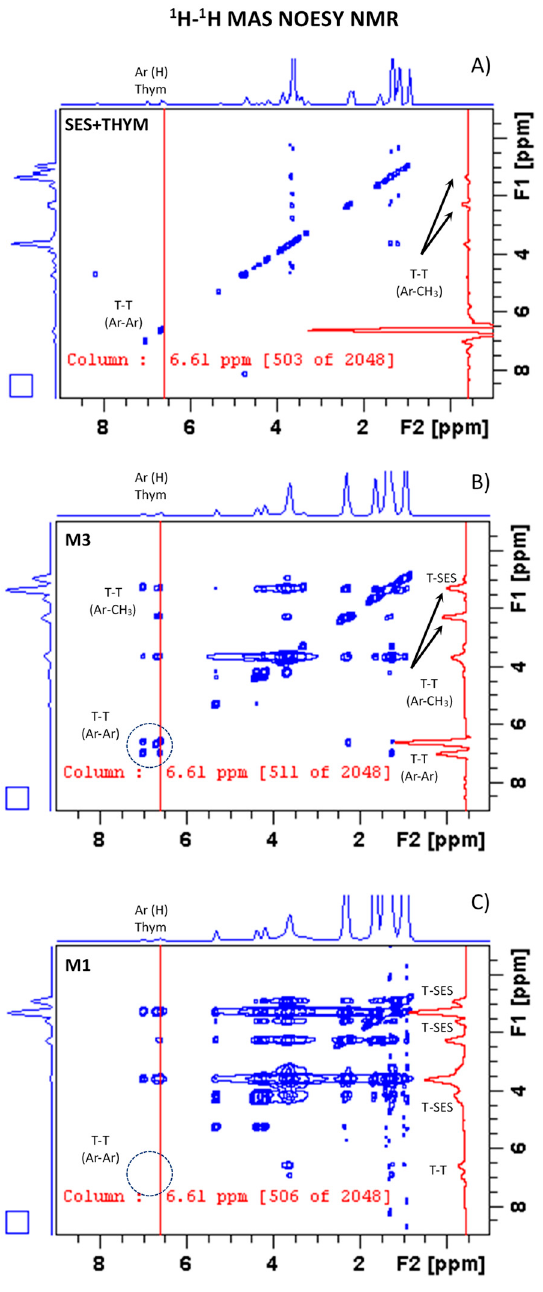
Figure 8. The 1 H- 1 H MAS NMR correlation spectra recorded for: ( A ) the pellet cores M1, ( B ) the pellet cores M3, ( C ) the model physical mixture SES + thymol. The spectra were recorded with a spin-diffusion mixing of 250 ms.